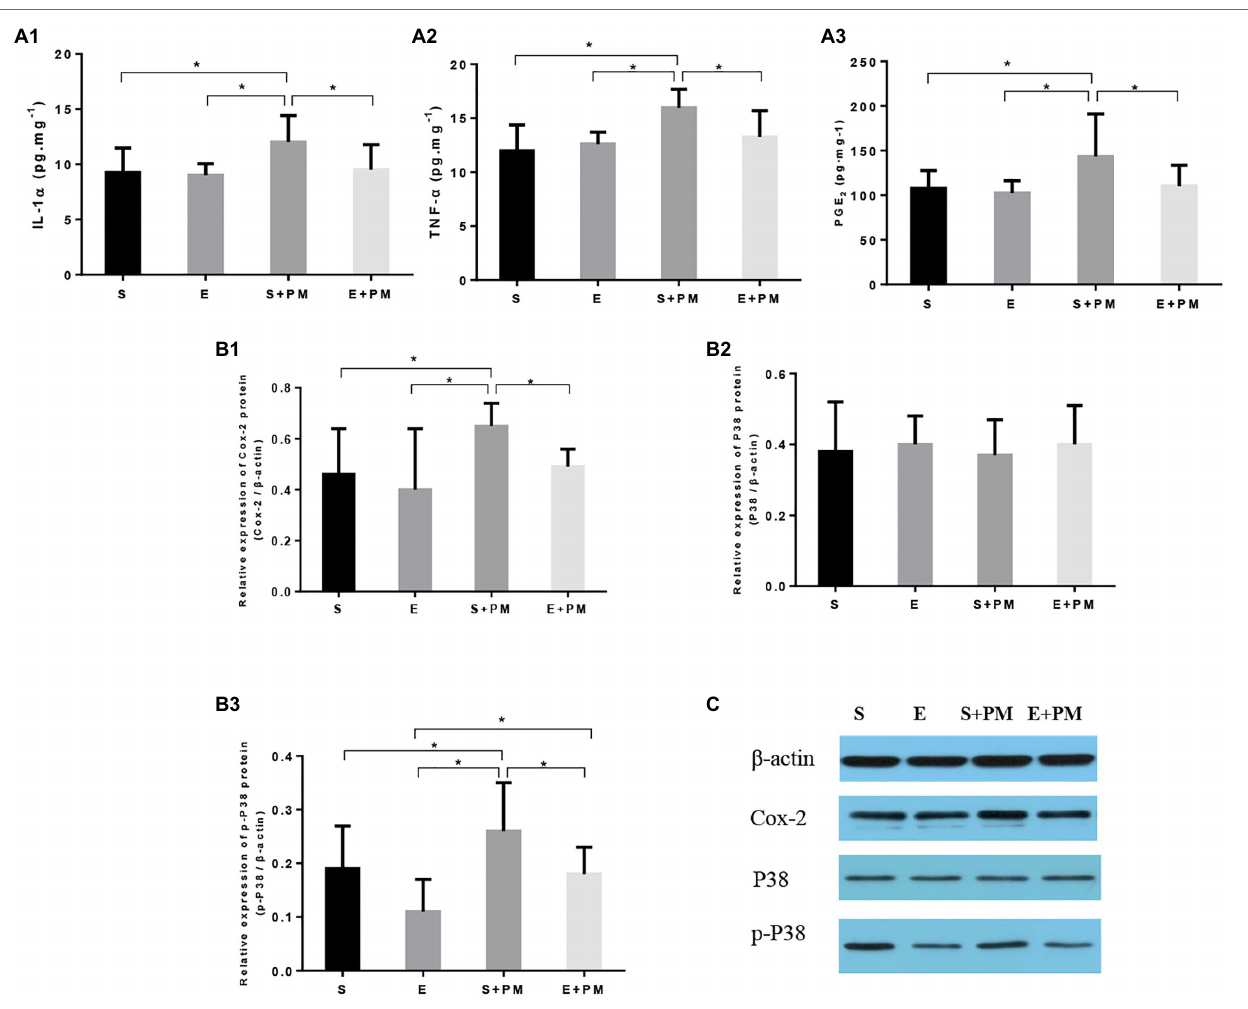
FIGURE 5 | Aerobic exercise suppressed PM 2.5 -induced lung inflammation in rats. (A1–A3) Pro-inflammatory cytokines (IL-1 α and TNF- α ) and PGE 2 in bronchoalveolar lavage fluid (BALF). (B1–B3) Protein levels of Cox-2, p38, and p-p38 in the lung tissues of rats. (C) Protein binding pattern determined by Western blot analysis. Data represent mean ± SD. * p < 0.05 between